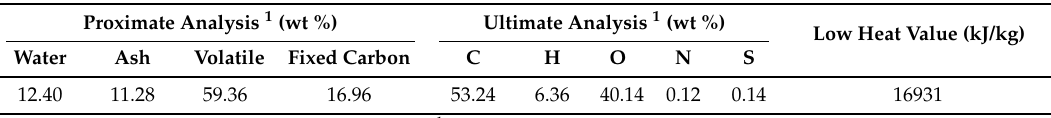
Table 1. Proximate and ultimate analysis of wood